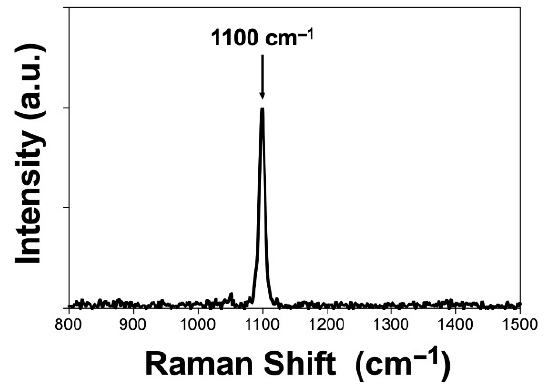
Figure 6. Raman spectrum of the scCO 2 -hpd, acquired with a 785 nm laser, 60 s acquisition time. BET isotherms (measured with adsorption of N 2 at 77.35 K) are shown in Figure 7a, these results show specific surface areas of 39.1 m 2 g − 1 for the DSA product, 70.4 m 2 g − 1 for the scCO 2 -od nesquehonite product, and a lower value of 19.8m 2 g − 1 for the scCO 2